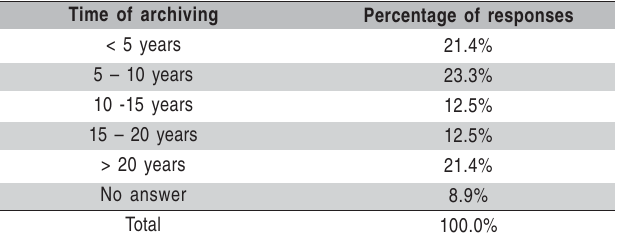
Table 5. Period of archiving of dental records after completion the orthodontic